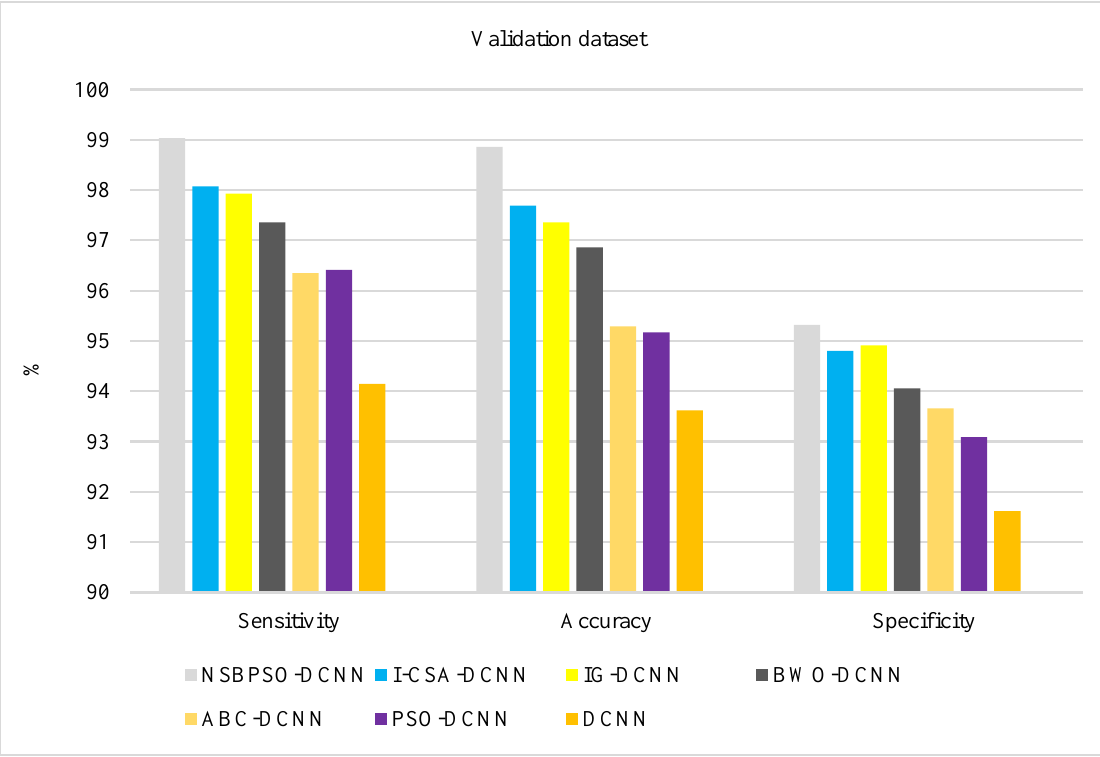
Figure 9. Comparison of the proposed architectures in the validation dataset.